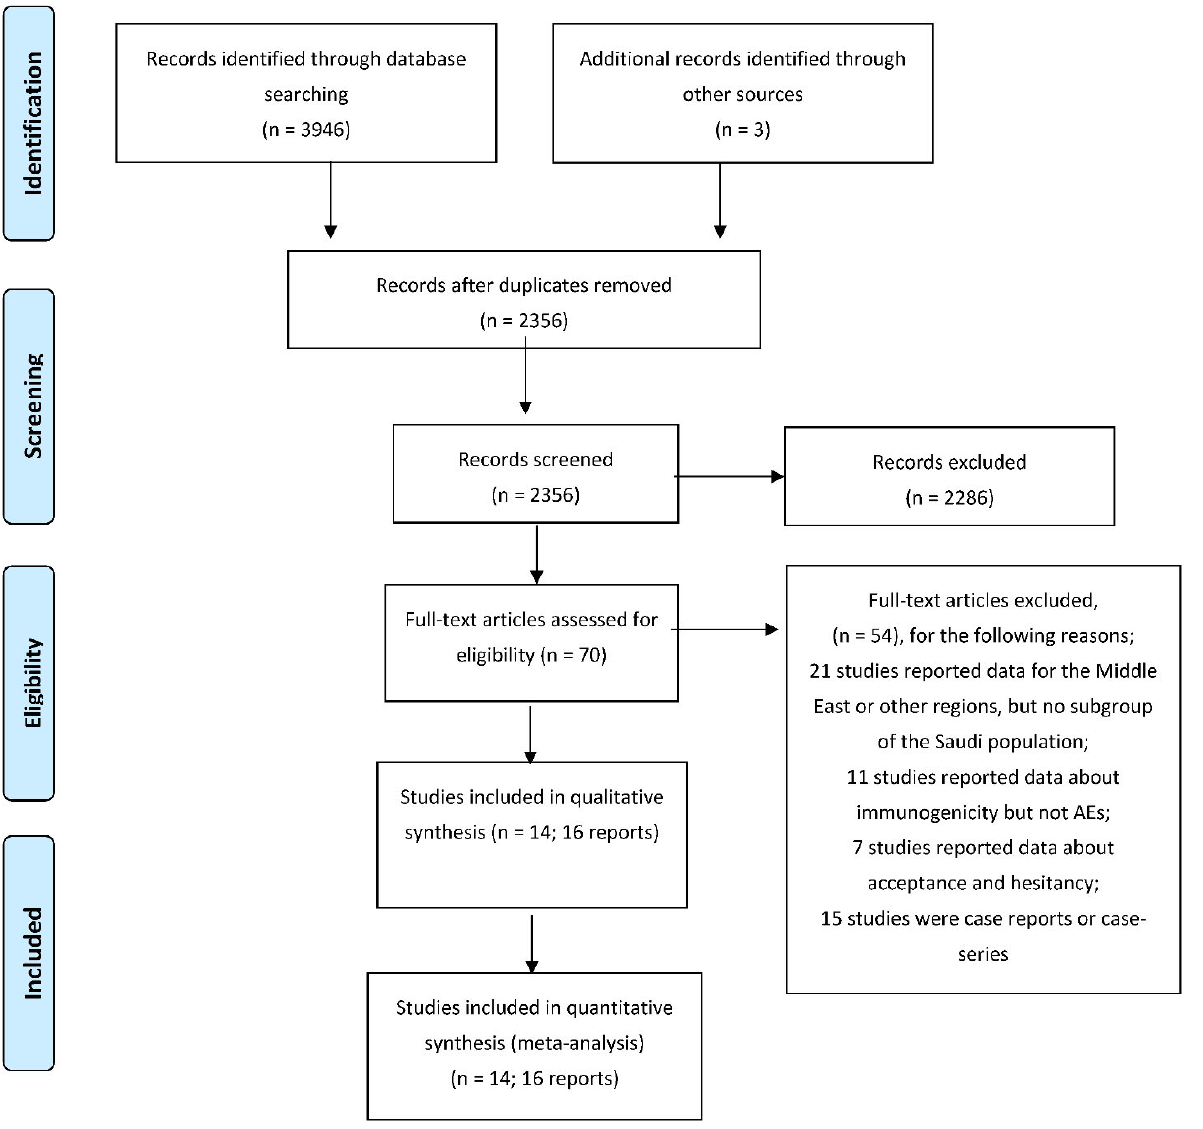
Figure 1. PRISMA flow diagram.